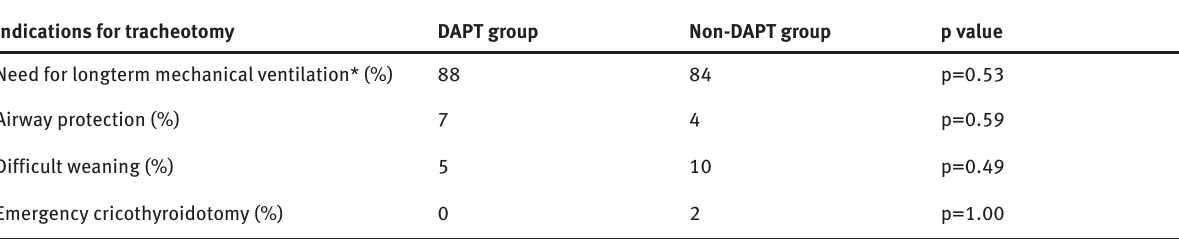
Table 2: Indications for tracheotomy.